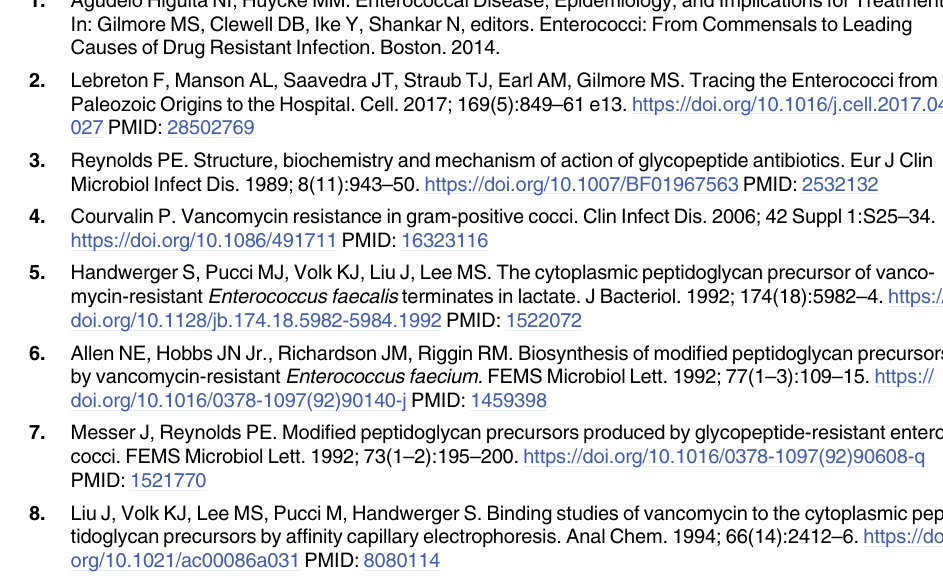
S1 Table. List of primers used in the